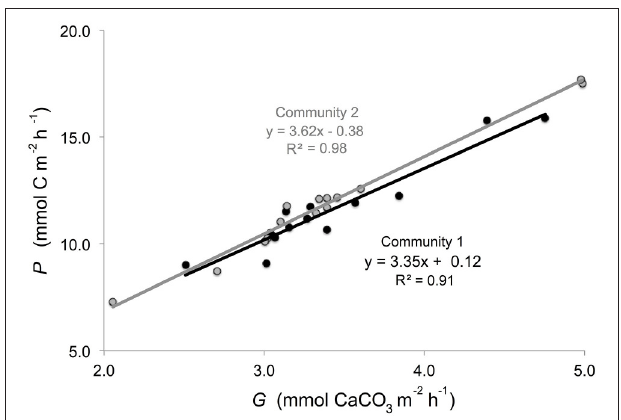
FIGURE 3 | Net production (mmol C m − 2 h − 1 ) of reef communities as a function of net calcification (mmol CaCO 3 m − 2 h − 1 ) in Community 1 (black) and Community 2 (gray). Slope and R 2 values are shown for each